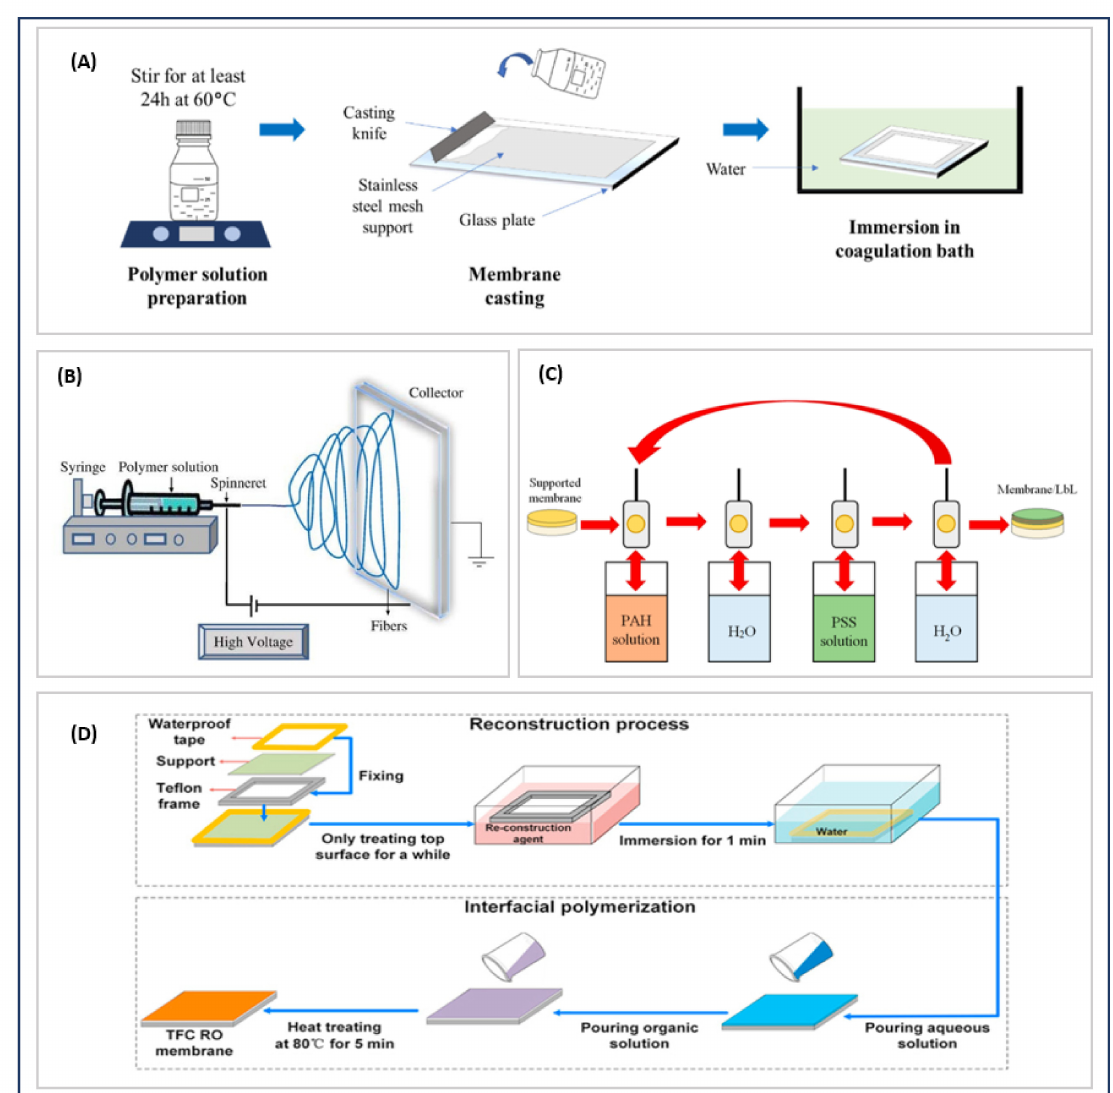
Figure 1. Schematic illustrations of membrane techniques. ( A ) Phase inversion [9] Reproduced from Doyan, A.; Leong, C.L.; Bilad, M.R.; Kurnia, K.A.; Susilawati, S.; Prayogi, S.; Narkkun, T.; Faungnawakij, K. Cigarette Butt Waste as Material for Phase Inverted Membrane Fabrication Used for Oil/Water Emulsion Separation. Polymers; published by MDPI, 2021. ( B ) Electrospinning [8] Reproduced from Tan, X. and Rodrigue, D., A Review on Porous Polymeric Membrane Preparation. Part I: Production Techniques with Polysulfone and Poly (Vinylidene Fluoride) Polymers; published by MDPI, 2019. ( C ) Layer by layer [10] Reproduced from Dmitrenko, M.; Kuzminova, A.; Zolotarev, A.; Ermakov, S.; Roizard, D.; Penkova, A. Enhanced Pervaporation Properties of PVA-Based Membranes Modified with Polyelectrolytes. Application to IPA Dehydration, Polymers; published by MDPI, 2021. ( D ) TFC manufacturing [11] Reproduced with permission from Shi, M.; Wang, Z.; Zhao, S.; Wang, J.; Wang, S. A Support Surface Pore Structure Re-Construction Method to Enhance the Flux of TFC RO Membrane; published by Journal of Membrane Science: published by Elsevier, 2017. Another approach to produce porous membranes is by stretching dense extruded films [4,12]. Stretching a dense film perpendicularly to its extrusion direction creates small breaks that result in pore formation. The stretching technique is generally used to prepare microfiltration (MF), ultrafiltration (UF), and membrane-distillation (MD) membranes, and is preferred for highly crystalline polymers